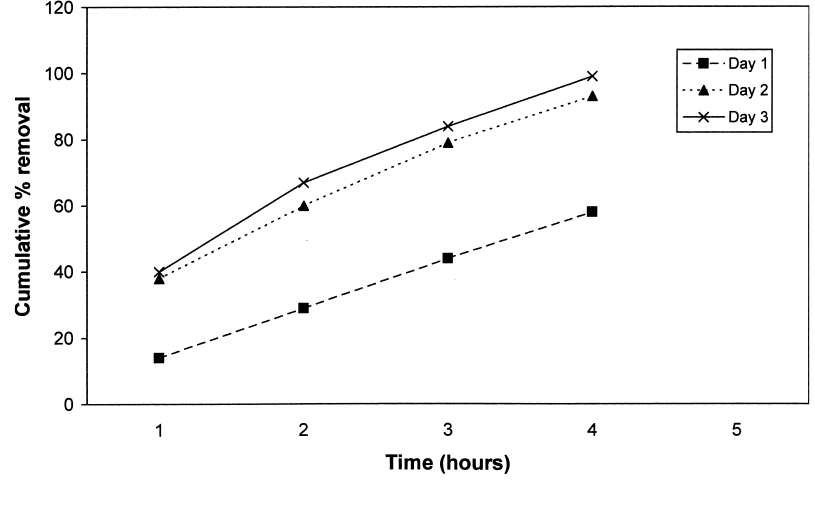
Fig. 5. Graph showing the effect of repeated baiting on the same road over a 3 d period related to removal